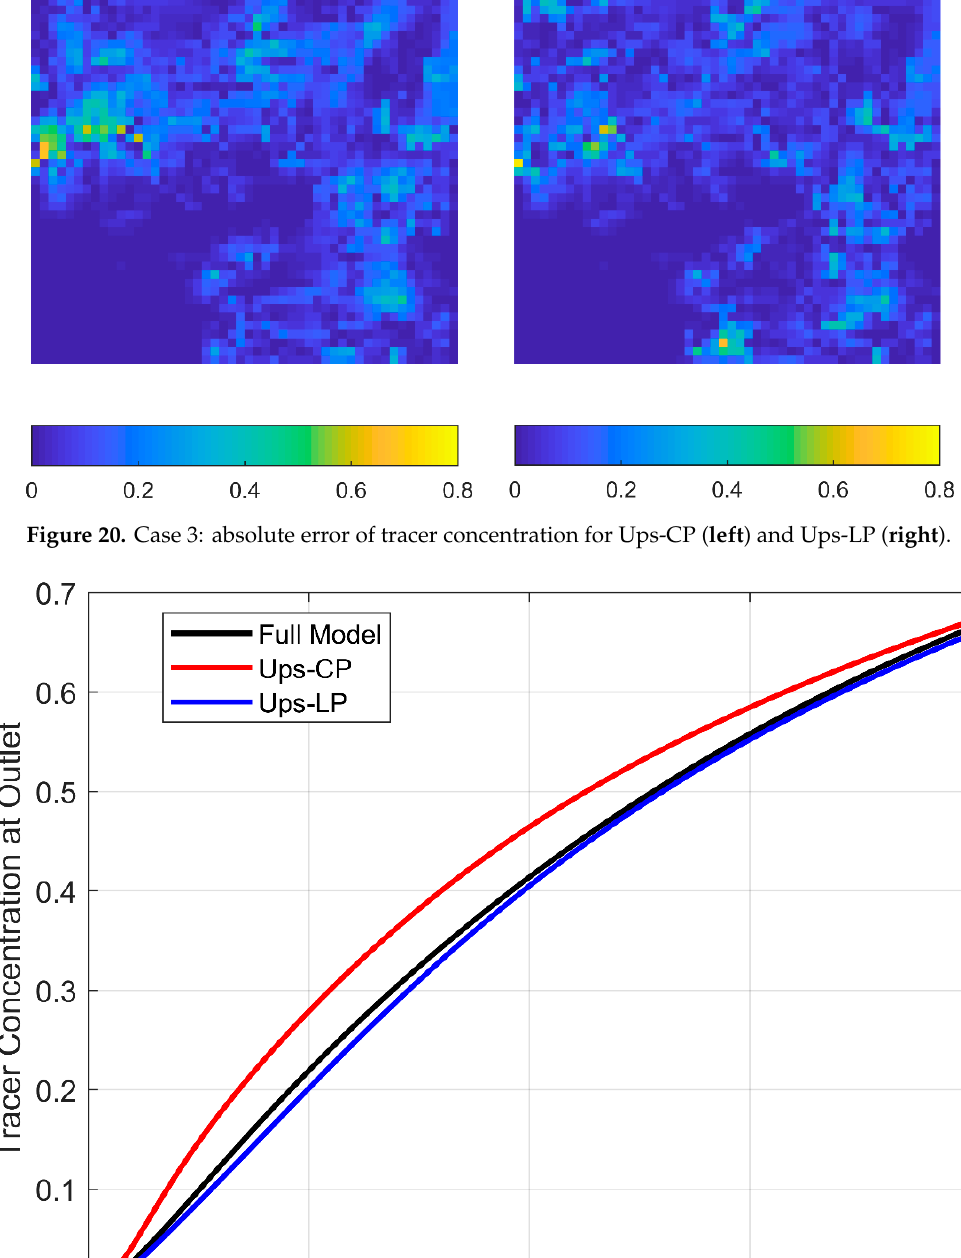
Figure 19. Case 3: relative error of pressure solutions for Ups-CP ( left ) and Ups-LP ( right ).